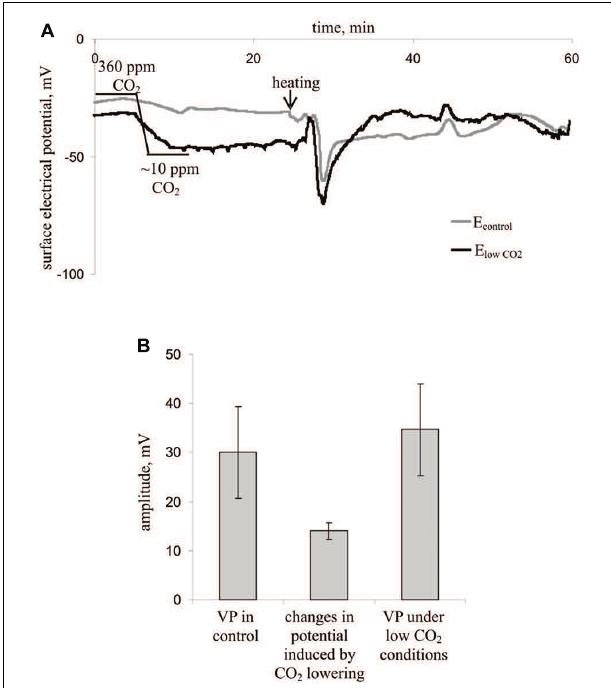
FIGURE 5 | Changes in the rate constant of the rapid relaxation of the electrochromic pigment absorbance shift (k ECS ), reflecting the proton conductivity of H + -ATP synthase, and the relative electrochromic shift, reflecting the proton motive force (relative ECS pmf ) induced by VP at 360 ppm (A) and approximately 10 ppm (B) CO 2 ( n = 5–6). The mean ECS pmf magnitudes prior to VP or a decrease in the CO 2 level were assumed to be 100%. Points were measured every 60 s (50 s light, 10 s dark). The VP was induced by burning the first mature leaf